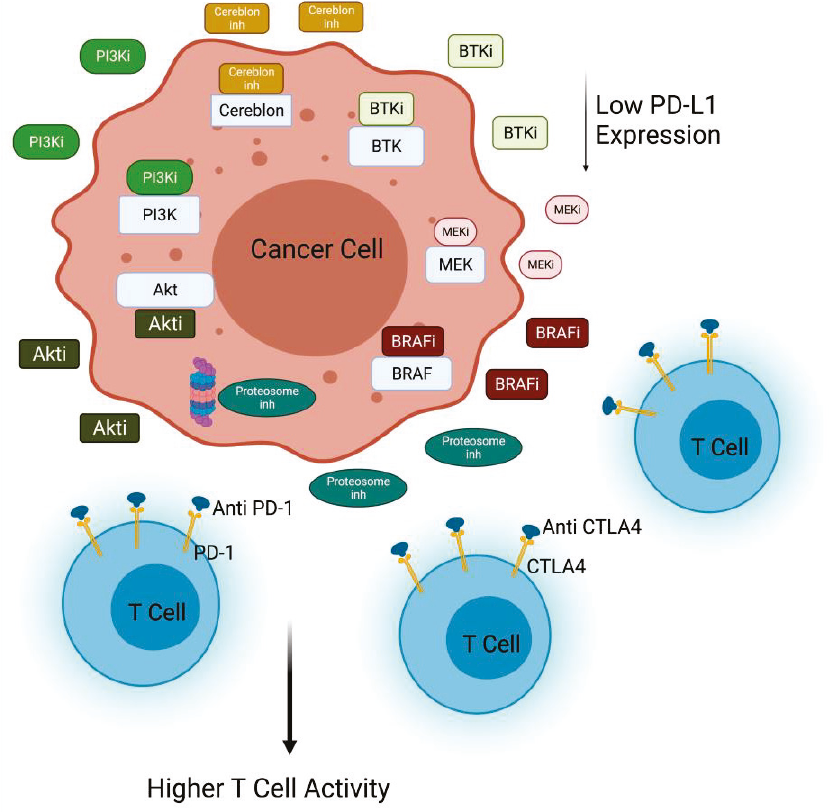
Figure 2. PI3K/Akt inactivation combined with immunomodulatory agents. Inhibition of PI3K or Akt decreases PD-L1 expression in cancer cells, contributing to the efficacy of anti-PD1 treatment. PI3K inhibitors in combination with different inhibitors (anti-CTLA4, BRAFi, BTKi, MEKi, Proteasome inhi) improves T cell killing activity against cancer cells (Created with BioRender.com: agreement number ZU22NUG38X).